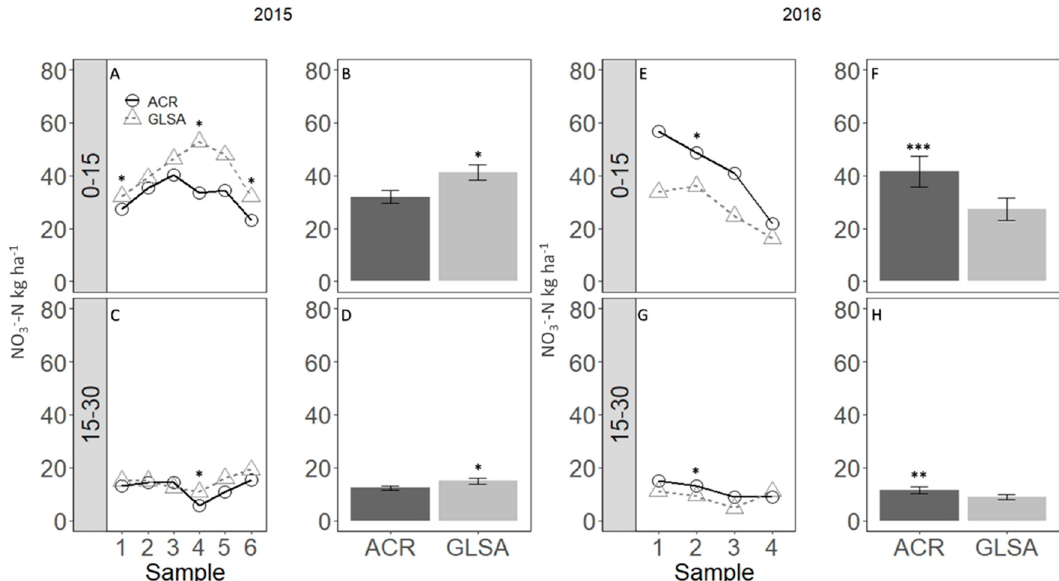
Figure 1. Average soil nitrate (NO 3 − -N) in 2015 from fields with annual crop rotations (ACR) and following a 3-year grassland set-aside (GLSA) at the 0–15 cm depth by sampling time ( A ) and seasonal average ( B ) and at the 15–30 cm depth by sampling time ( C ) and seasonal average ( D ); average soil nitrate (NO 3 − -N) in 2016 from fields with ACR and following a 3-year GLSA at the 0–15 cm depth by sampling time ( E ) and seasonal average ( F ) and at the 15–30 cm depth by sampling time ( G ) and seasonal average (H ). Error bars represent one standard error of the mean (n = 4). Significant differences are indicated by * ( p < 0.05), ** ( p < 0.01), and *** ( p < 0.001) .